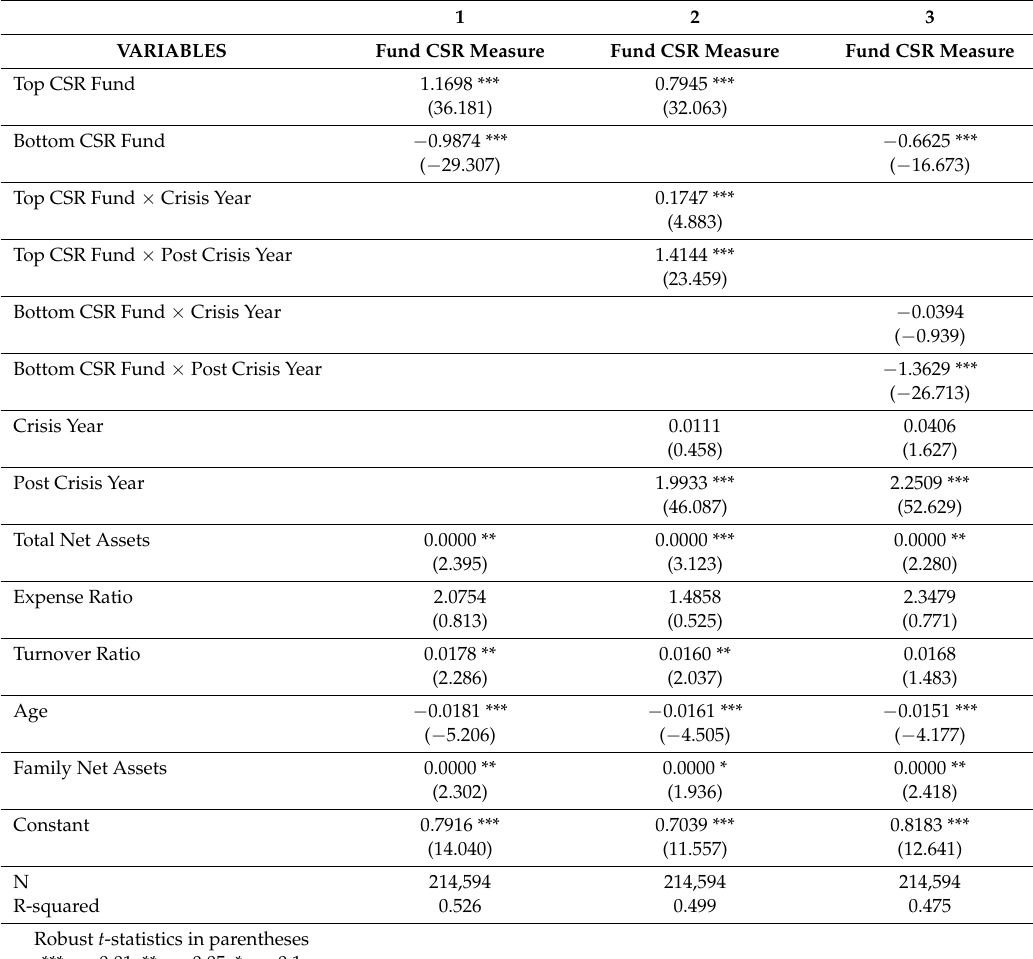
Table 8. Fund CSR measure, financial crisis and post-crisis period (Fixed effect